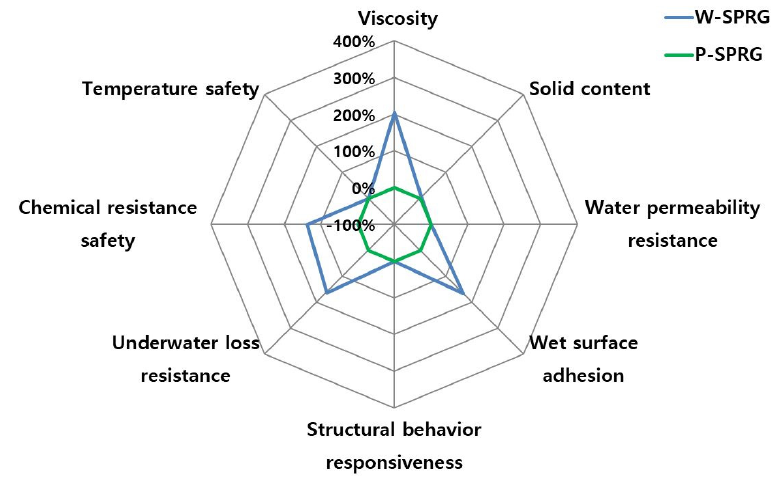
Figure 14. Comparison of improvement level of W-SPRG compared to P-SPRG.